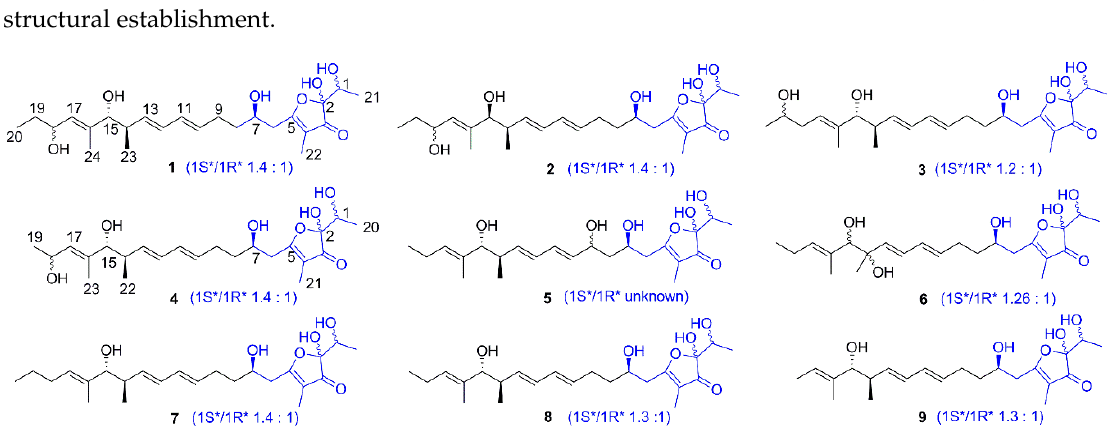
Figure 1. Structures of compounds 1 – 9 .